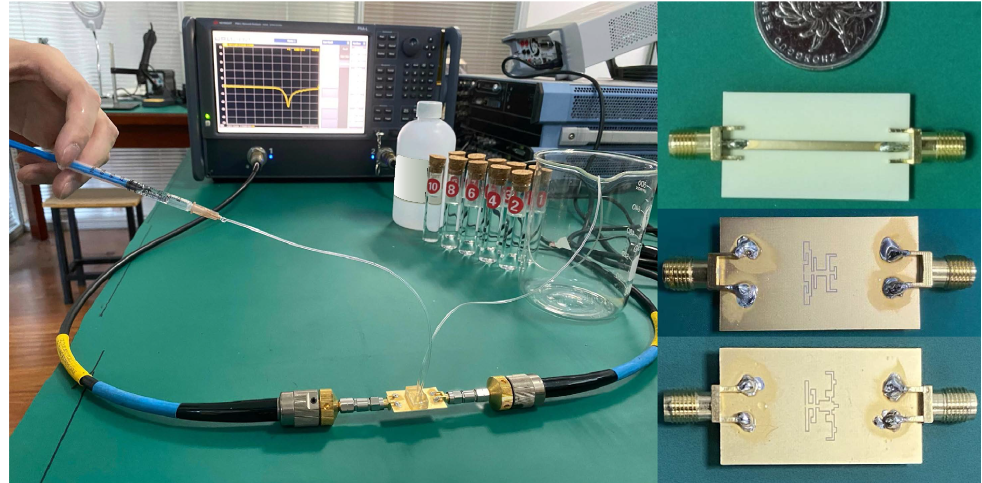
Figure 26. Photographs of the experimental setup and the optimized sensors. The right, middle is the sensor optimized to minimize the volume of the liquid sample and the right, bottom is that optimized with a fixed volume of sample under test. Reprinted with permission from Ref. [85].